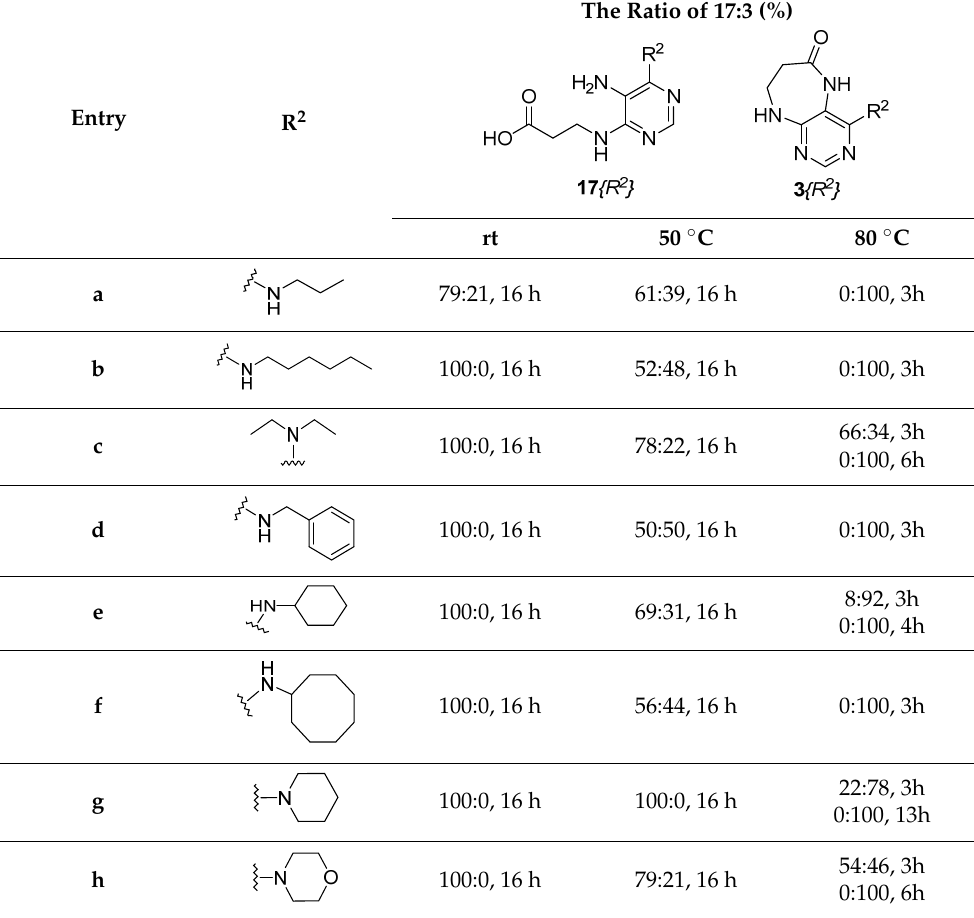
Table 4. Overview of synthesized pyrimidodiazepinones 3 .